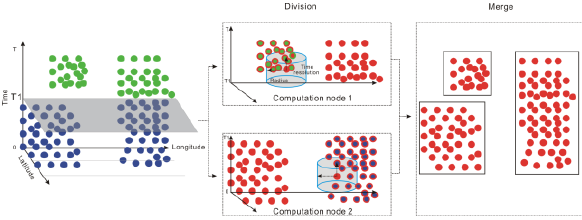
Figure 1. TCCA aggregating individual stopping locations.